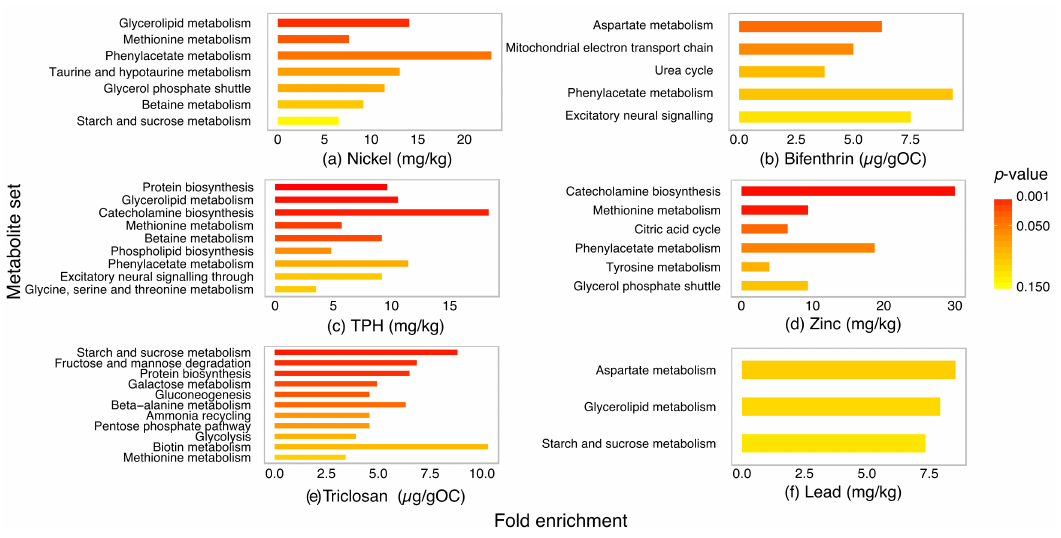
Figure 6. Results of an overrepresentation analysis (ORA) of important and marginally important metabolites (>3%IncMSE from random forest modelling) from GC-MS and LC-MS analysis of Procladius villosimanus associated with nickel ( a ), bifenthrin ( b ), total petroleum hydrocarbons (TPH) ( c ), zinc ( d ), triclosan ( e ) and lead ( f ). Color gradient indicates the p -value associated with each metabolite